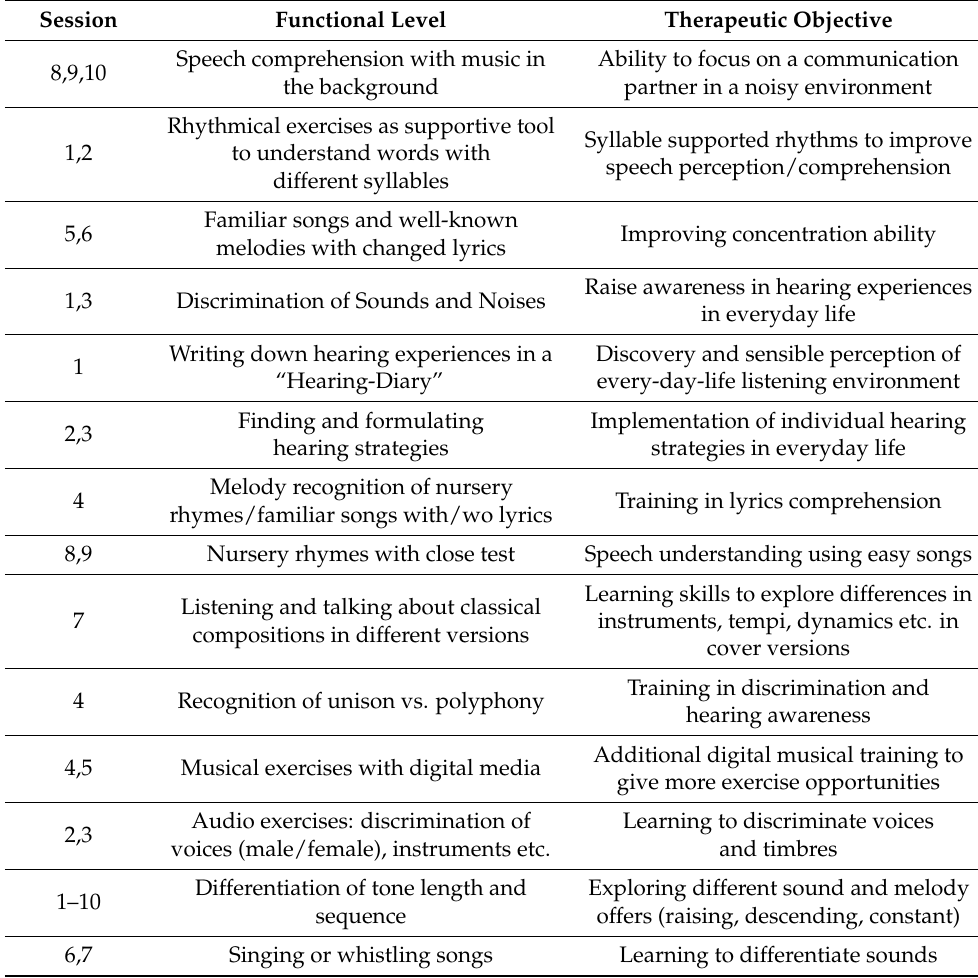
Table 1. Description of the Therapy